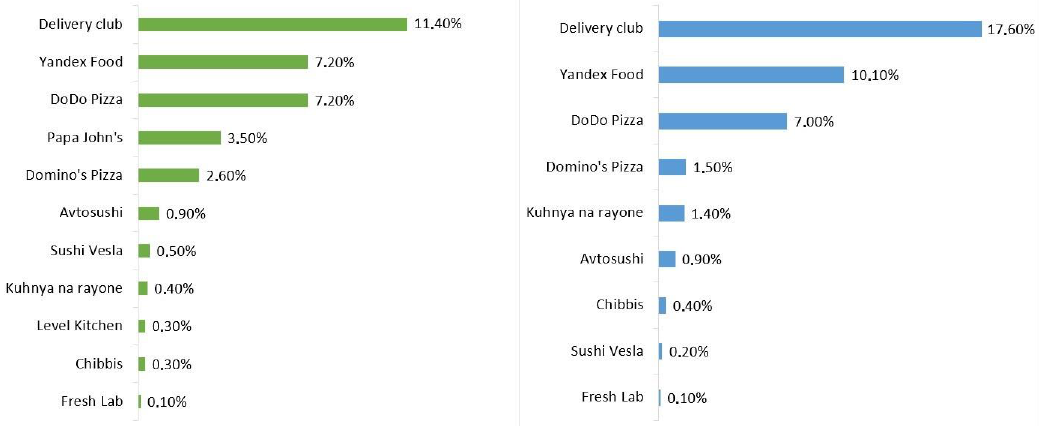
Figure 1. Market shares of leading players for 2019 – 2020.